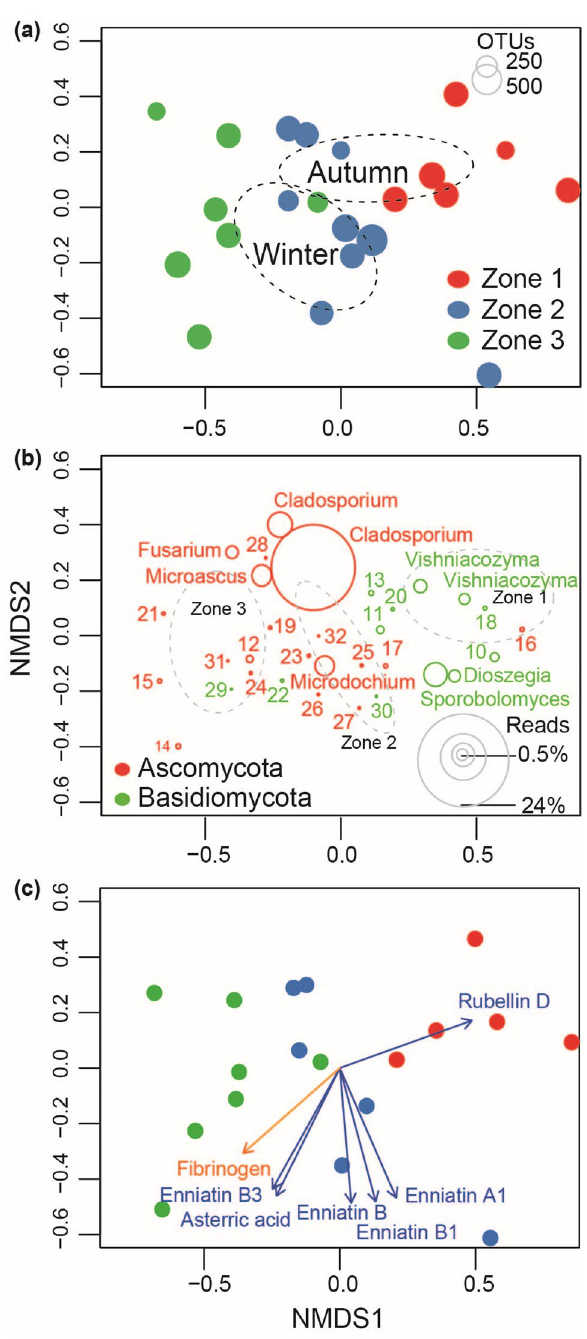
Figure 3. Nonmetric multidimensional scaling (NMDS) ordination analysis of airborne fungal communities in the Norwegian grain industry. ( a ) Plot represents air samples (n = 22) color coded by climatic zone (three) and ellipses representing the 95% confidence interval for the centroids of two different sampling seasons (autumn and winter). ( b ) Plot showing fungal operational taxonomic units (OTUs) composition of industrial grain mill air. The ordination plot is based on all fungal OTUs present, but only the most common 32 OTUs are shown here, which accounted for 86% of the total reads (m = million reads). ( c ) Plot represents industrial grain mill air samples (n = 18), from which mycotoxin data could be collected. Vectors (mycotoxin [blue] and fibrinogen [orange] variables) had significant effects (p < 0.05) on the ordination configuration. Numerical prefixes represent OTUs with taxonomic identity to following genera: Itersonilia (10), Vishniacozyma (11), Gibberella (12), Vishniacozyma (13), unclassified Phaeosphaeriaceae (14), Alternaria (15), Aspergillus (16), Gibberella (17), Vishniacozyma (18), unclassified Ascomycota (19), Dioszegia (20), Epicoccum (21), Sporobolomyces (22), Bipolaris (23), unclassified Pleosporales (24), Botrytis (25), Alternaria (26), Sclerotinia (27), Aspergillus (28), Dioszegia (29), Filobasidium (30), Gibberella (31) and Neoascochyta